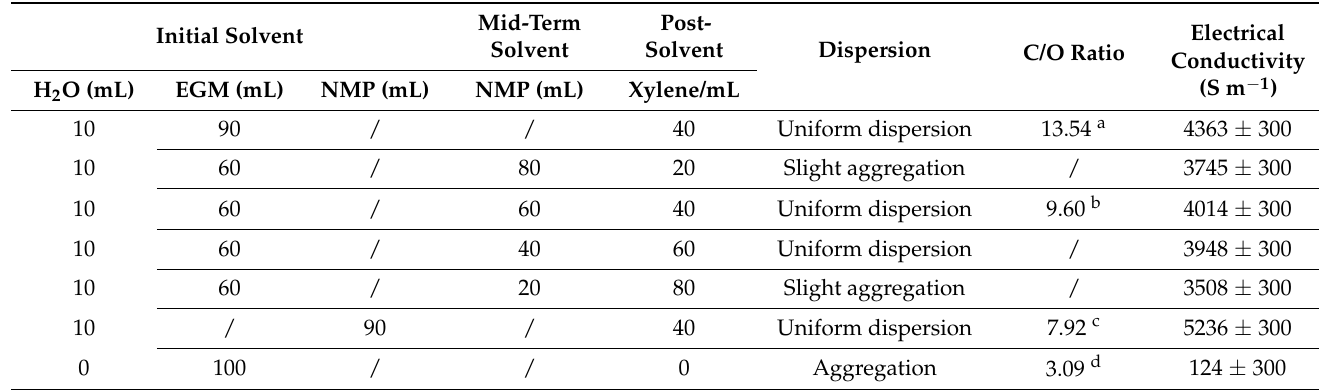
Table 2. RGO in the gradient solvent system.